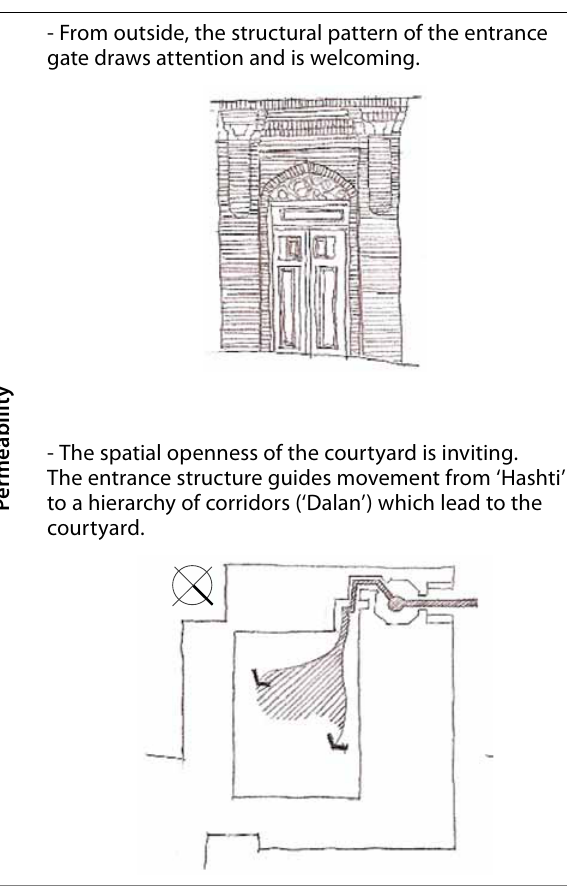
Table 1 . responsiveness to functional-constructional